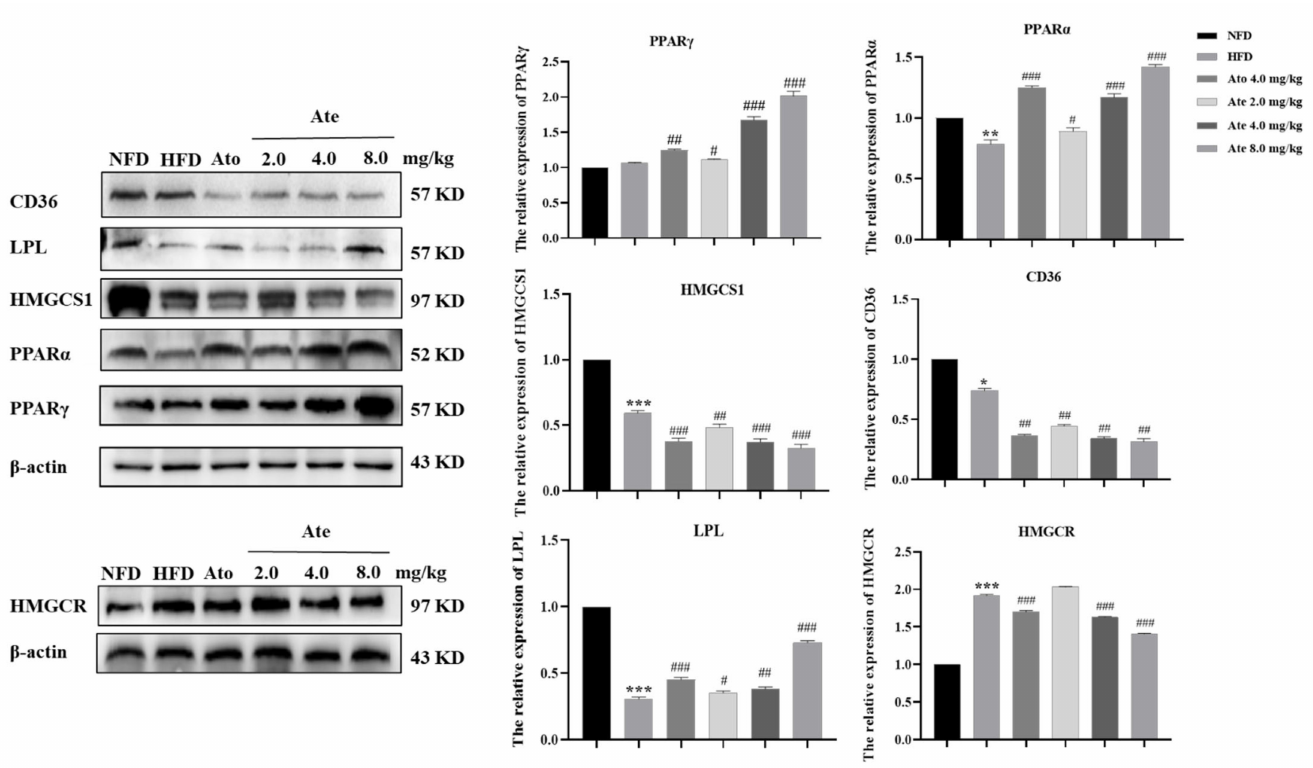
Figure 9. The effects of Ate on the PPAR-signaling pathway proteins and HMGCR protein expression in the liver of hyperlipidemia rats. The expression of PPAR α , PPAR γ , HMGCS1, CD36, LPL, and HMGCR after modeling and after treatment with Ate. All data are shown as mean ± SEM, n = 3. * p < 0.05, ** p < 0.01 and *** p < 0.001 compared with the NFD group; # p < 0.05, ## p < 0.01 and ### p < 0.001 compared with the HFD